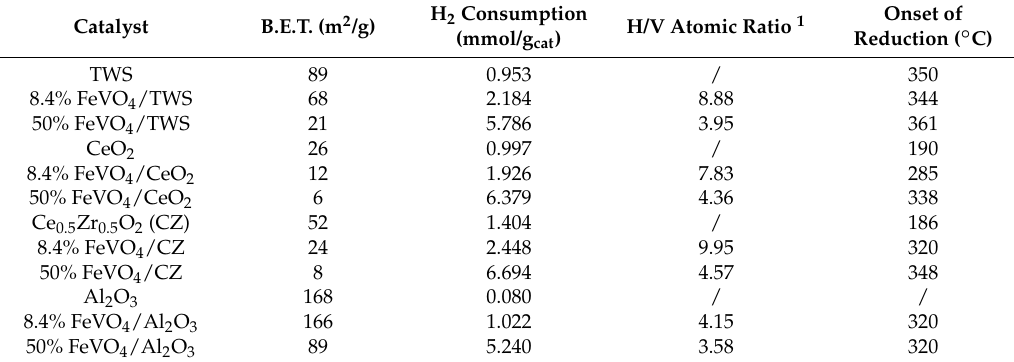
Table 1. B.E.T. surface areas, hydrogen consumption in TPR, H/V atomic ratio and onset temperature of reduction for each